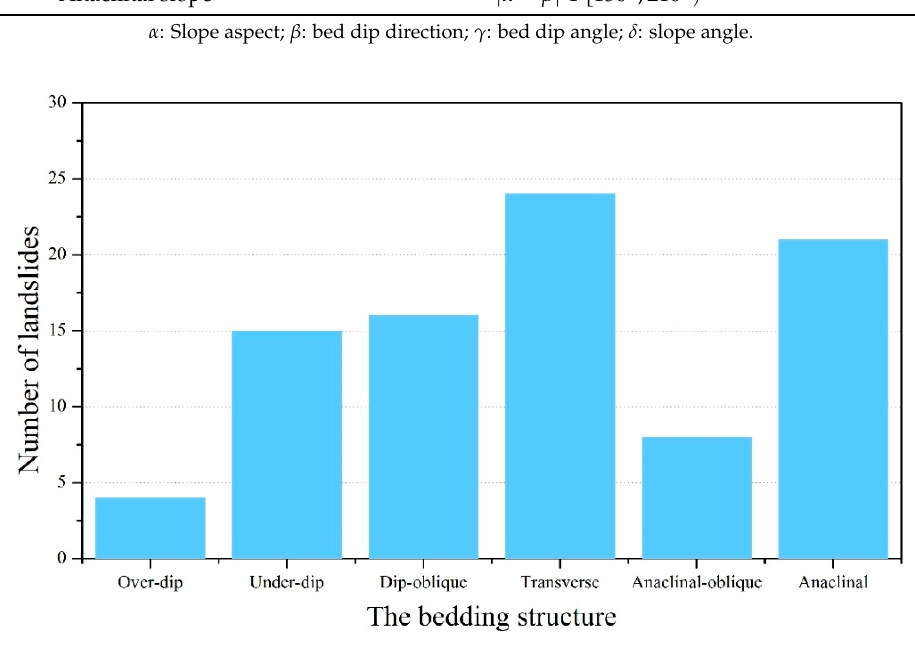
Figure 9. Statistical results of the numbers of landslides corresponding to different bedding structures.